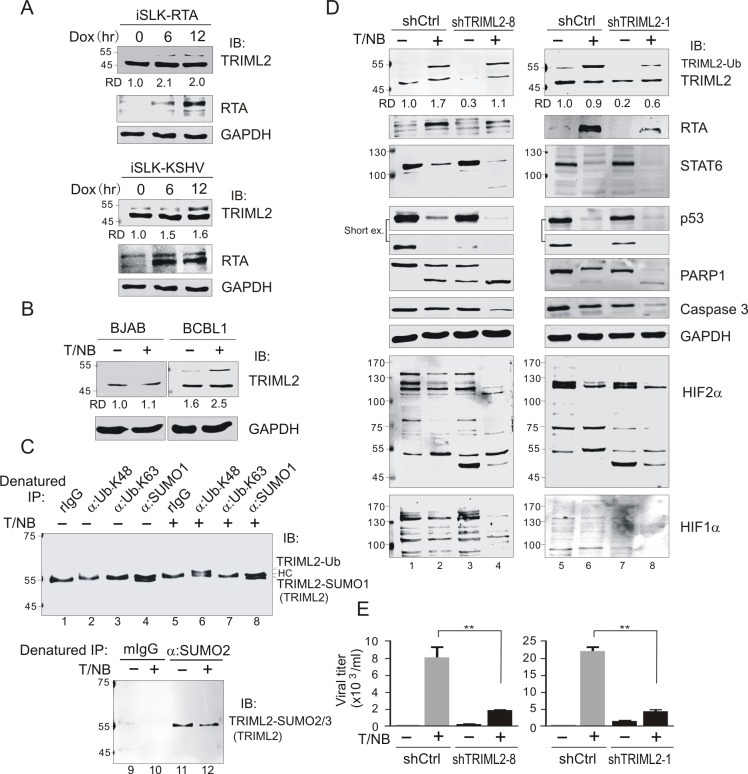
TRIML2 contributes to KSHV lytic replication and cellular anti-apoptosis.(A) RTA induced the expression and ubiquitylation of TRIML2. iSLK cells carrying doxycline-induced RTA (iSLK-RTA) or RTA and KSHV whole genome (iSLK-KSHV) were treated with doxycline for different time points, and subjected to immunoblotting as indicated in figure. (B) Reactivation of KSHV in PEL cells induced expression and ubiquitylation of TRIML2. KSHV-negative B lymphoma BJAB and KSHV-positive BCBL1 cells were individually treated with or without TPA/sodium butyrate (T/NB) for 24 h, and subjected to immunoblotting as indicated. (C) K48-linked ubiquitylation of TRIML2 was induced during KSHV reactivation. Whole cell lysates (WCLs) of BCBL1 described in panel B were lysed and aliquoted equally for denatured immunoprecipitation (IP) with antibodies specific against K48 or K63 polyubiquitin, SUMO1 and SUMO2/3, respectively, and immunoblotting (IB) for TRIML2. Rabbit and mouse IgG (rIgG, mIgG) were individually used as negative control. (D) Knockdown of TRIML2 reduced the expression of RTA and anti-apoptosis ability of KSHV-infected PEL cells. BCBL1 cells with TRIML2 (shTRIML2-8, or shTRIML2-1) or luciferase control (shCtrl) stable knockdown were individually treated with or without TPA/NaB (T/NB) for 24 h, and subjected to immunoblotting as indicated. (E) TRIML2 knockdown reduced TPA- and sodium butyrate-induced KSHV virion production. The supernatants from equal amounts cells in panel D were purified to quantitate virion production. The statistical significance was evaluated and p<0.05 indicated as double asterisks.